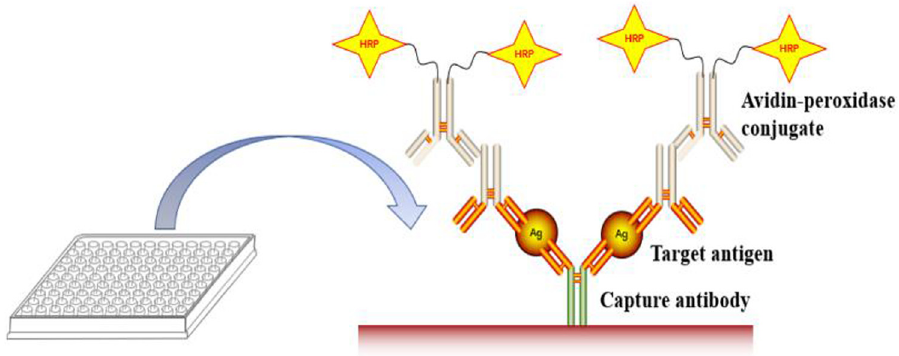
Figure 2: Schematic representation of “ sandwich ”